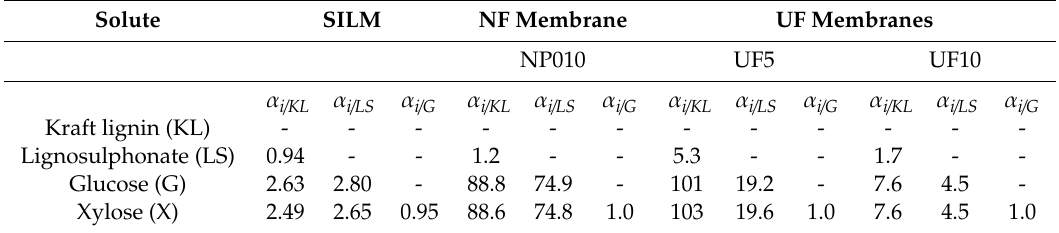
Table 5. Separation factors α ij of the di ff erent solutes for the SILM and NF and UF membranes. Solute SILM NF